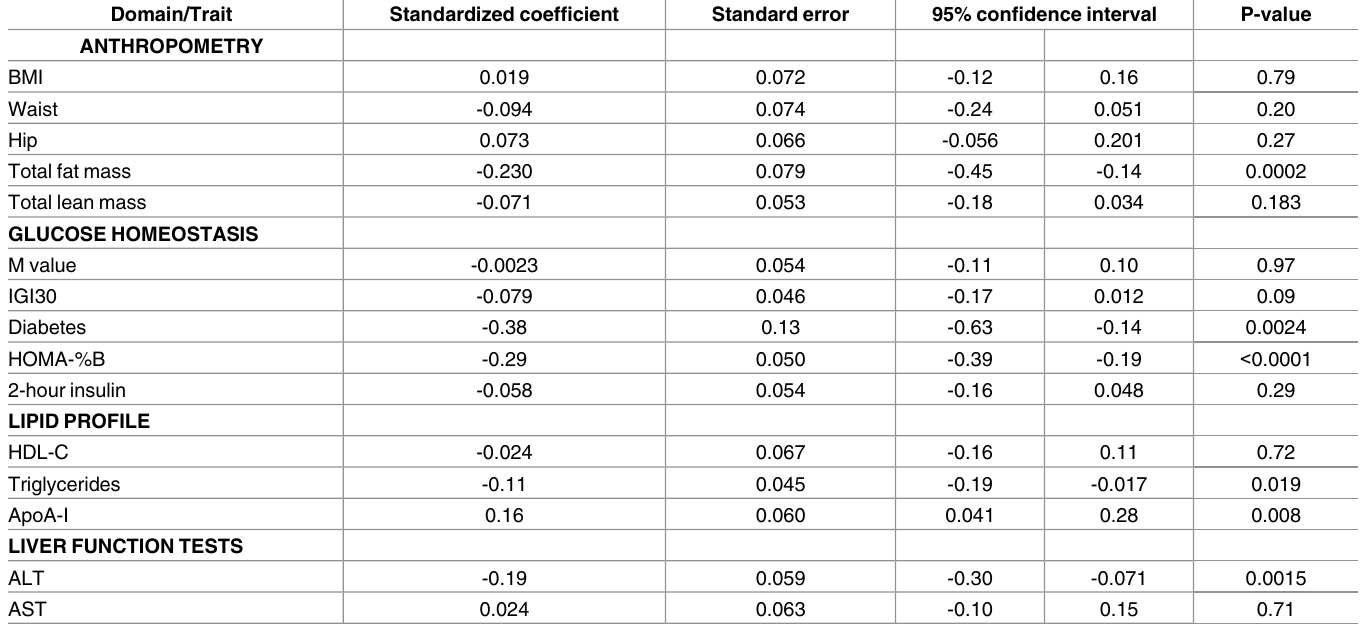
Table 2. Multivariate analyseswithin each domain.